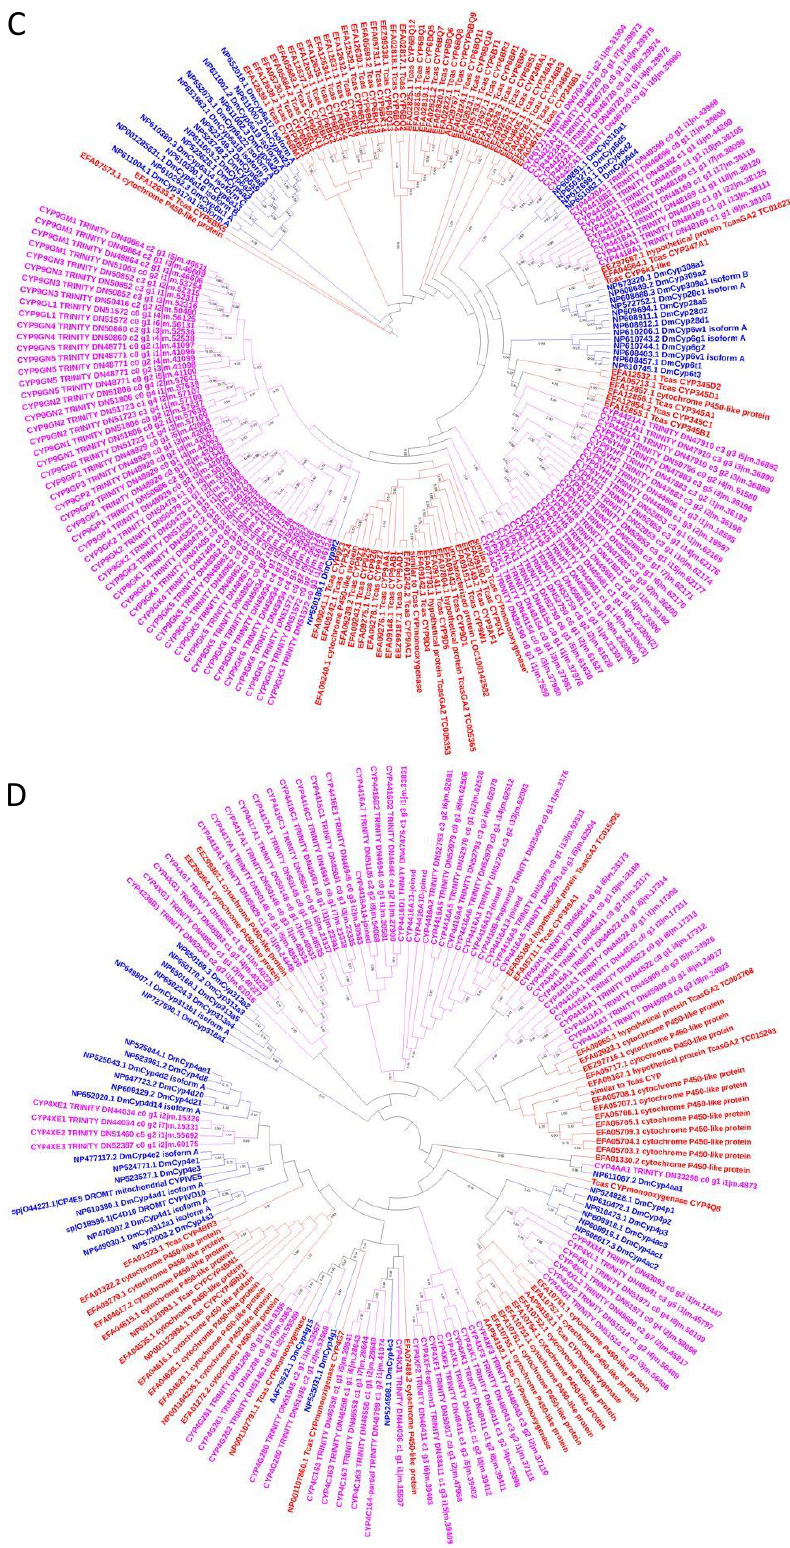
Figure 6. Neighbor-joining consensus trees of the four P450 clans. ( A ). CYP2 clan; ( B ). mitochondrial clan; ( C ). CYP3 clan; and ( D ). CYP4 clan. The phylogenetic tree was generated with 1000 Bootstrap cutoff by MEGA 7 using the amino acid sequences for CYPs from T. castaneum and D. melanogaster . Node labels are colored pink for C. zastrowi sillemi , red for T. castaneum , and blue for D. melanogaster . Tcas: T. castaneum , Dm: D. melanogaster .